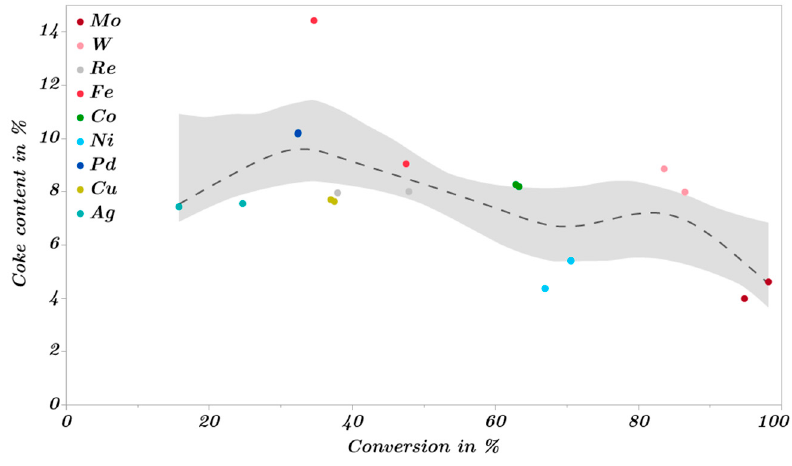
Figure 23. Dependence of the coke content on the conversion at 400 °C. The dashed smoothing is based on a spline with λ = 0.05.